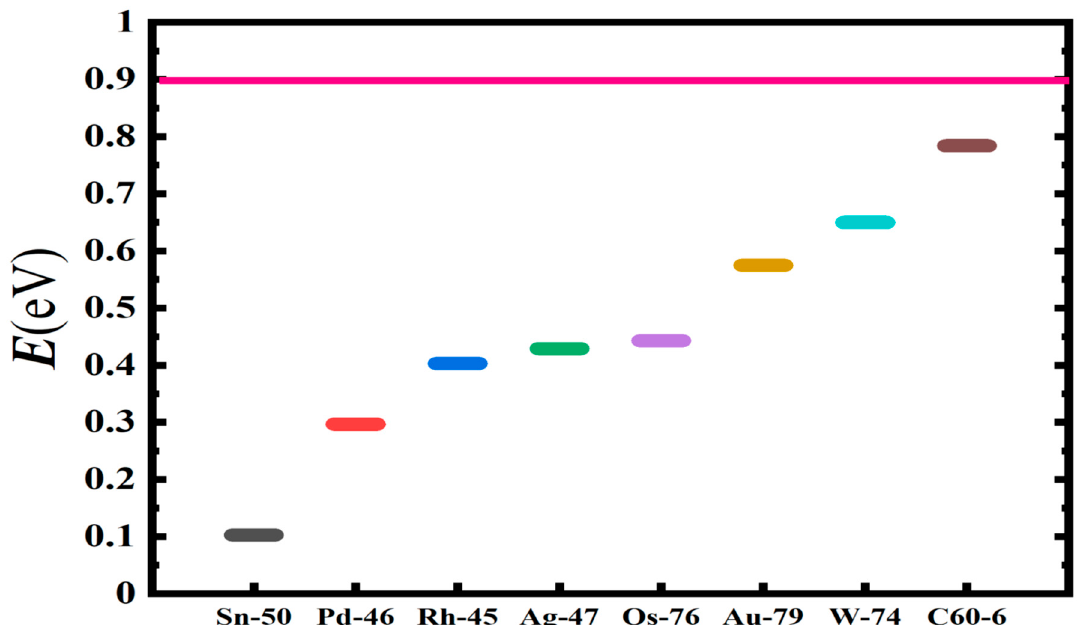
Figure 8. Transition state energy barrier reduction, E(eV), for selected doubly-charged anionic systems of popular catalysts in ascending order of catalytic effectiveness. The horizontal axis shows the not-to-scale catalyzing systems. The pink line represents the energy position with no catalyst present.